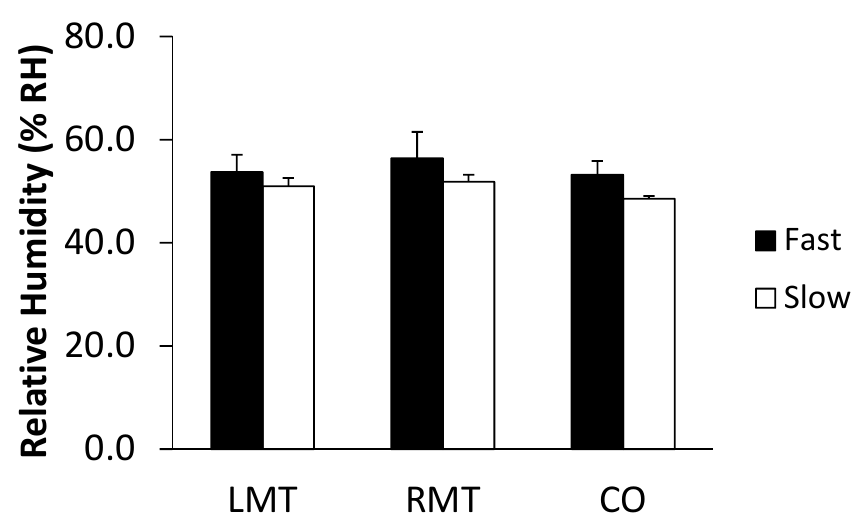
Figure 8. Averaged relative humidity (RH) values based on 10 sets of measurements including the last five measuring points from each of the three sensitive locations: left mid-thigh (LMT), right mid-thigh (RMT) and coccyx (CO), when the participant sat down at different speeds (fast: 10.29 ± 0.90 cm/s; slow: 6.78 ± 0.43 cm/s). Error bars denote the first standard deviation. The ambient temperature and RH parameters were 24.7 ℃ ± 0.2 ℃ and 38.6% ± 0.4% RH, respectively.